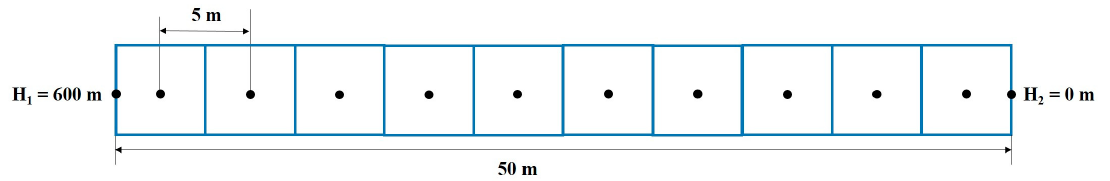
Figure 2. One-dimensional channel system applied to verify the RWPF (Random Walk Particle Following) model.